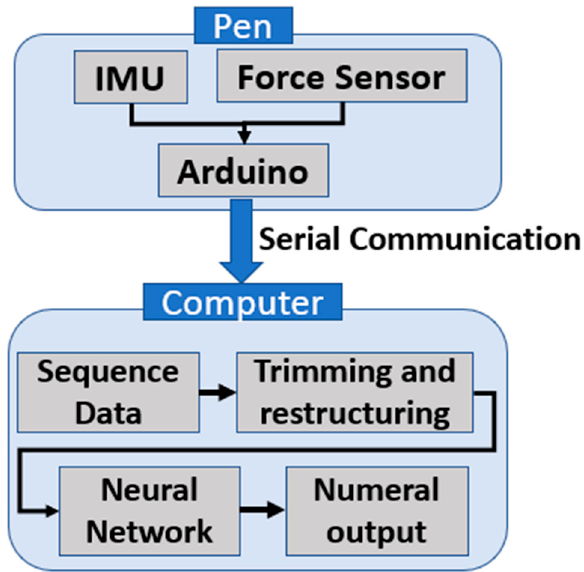
Figure 3. Overall system